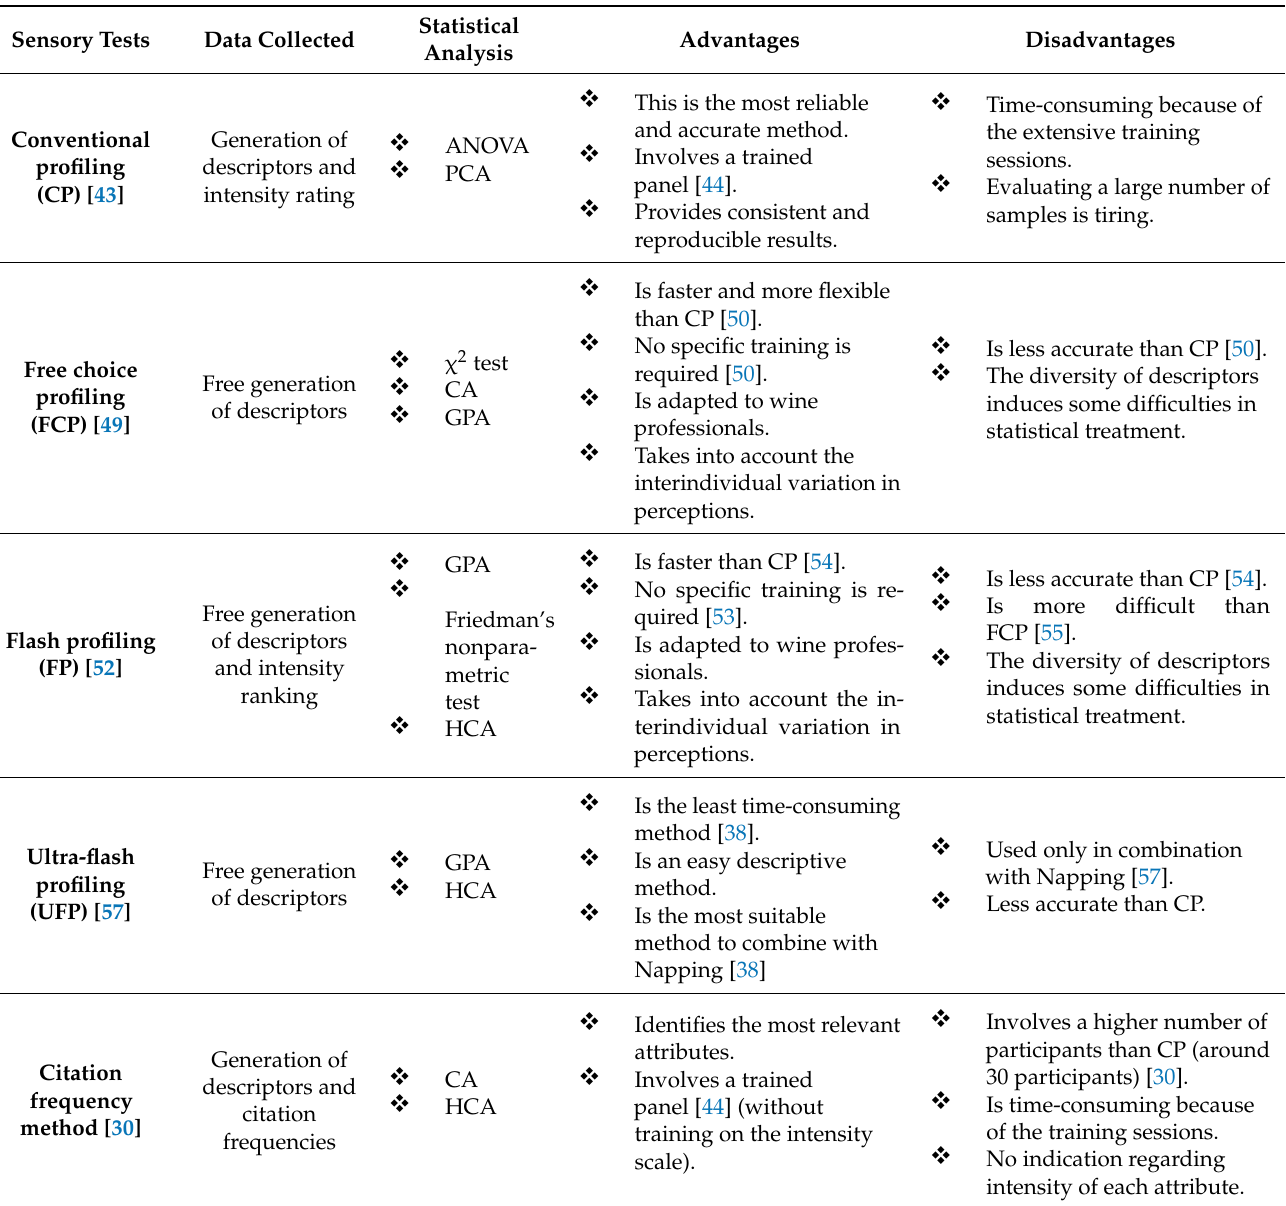
Table 2. Inventory of perceptual methodologies used to describe sensory space. Statistical analysis—ANOVA: analysis of variance; PCA: principal component analysis; CA: correspondence analysis; GPA: generalized procrustes analysis; HCA: Table 1. Inventory of perceptual methodologies used to evaluate sensory space. Statistical analysis—MDS: multi-dimen- Table 1. Inventory of perceptual methodologies used to evaluate sensory space. Statistical analysis—MDS: multi-dimen- hierarchical cluster analysis. sional scaling; HCA: hierarchical cluster analysis; MFA: multiple factor analysis; PCA: principal component analysis; sional scaling; HCA: hierarchical cluster analysis; MFA: multiple factor analysis; PCA: principal component analysis; Table 1. Inventory of perceptual methodologies used to evaluate sensory space. Statistical analysis—MDS: multi-dimen- ANOVA: analysis of variance. Table 1. Inventory of perceptual methodologies used to evaluate sensory space. Statistical analysis—MDS: multi-dimen- ANOVA: analysis of variance. Table 1. Inventory of perceptual methodologies used to evaluate sensory space. Statistical analysis—MDS: multi-dimen- sional scaling; HCA: hierarchical cluster analysis; MFA: multiple factor analysis; PCA: principal component analysis; sional scaling; HCA: hierarchical cluster analysis; MFA: multiple factor analysis; PCA: principal component analysis; Table 1. Inventory of perceptual methodologies used to evaluate sensory space. Statistical analysis—MDS: multi-dimen- sional scaling; HCA: hierarchical cluster analysis; MFA: multiple factor analysis; PCA: principal component analysis; ANOVA: analysis of variance. Table 1. Inventory of perceptual methodologies used to evaluate sensory space. Statistical analysis—MDS: multi-dimen- ANOVA: analysis of variance. sional scaling; HCA: hierarchical cluster analysis; MFA: multiple factor analysis; PCA: principal component analysis; ANOVA: analysis of variance. sional scaling; HCA: hierarchical cluster analysis; MFA: multiple factor analysis; PCA: principal component analysis; ANOVA: analysis of variance. ANOVA: analysis of variance. Table 1. Inventory of perceptual methodologies used to evaluate sensory space. Statistical analysis—MDS: multi-dimen- sional scaling; HCA: hierarchical cluster analysis; MFA: multiple factor analysis; PCA: principal component analysis; panel [44]. Table 1. Inventory of perceptual methodologies used to evaluate sensory space. Statistical analysis—MDS: multi-dimen- Table 1. Inventory of perceptual methodologies used to evaluate sensory space. Statistical analysis—MDS: multi-dimen- ANOVA: analysis of variance. Provides consistent and Table 1. Inventory of perceptual methodologies used to evaluate sensory space. Statistical analysis—MDS: multi-dimen- sional scaling; HCA: hierarchical cluster analysis; MFA: multiple factor analysis; PCA: principal component analysis; Table 1. Inventory of perceptual methodologies used to evaluate sensory space. Statistical analysis—MDS: multi-dimen- sional scaling; HCA: hierarchical cluster analysis; MFA: multiple factor analysis; PCA: principal component analysis; reproducible results. Table 1. Inventory of perceptual methodologies used to evaluate sensory space. Statistical analysis—MDS: multi-dimen- sional scaling; HCA: hierarchical cluster analysis; MFA: multiple factor analysis; PCA: principal component analysis; ANOVA: analysis of variance. Table 1. Inventory of perceptual methodologies used to evaluate sensory space. Statistical analysis—MDS: multi-dimen- sional scaling; HCA: hierarchical cluster analysis; MFA: multiple factor analysis; PCA: principal component analysis; ANOVA: analysis of variance. Table 1. Inventory of perceptual methodologies used to evaluate sensory space. Statistical analysis—MDS: multi-dimen- sional scaling; HCA: hierarchical cluster analysis; MFA: multiple factor analysis; PCA: principal component analysis; ANOVA: analysis of variance. sional scaling; HCA: hierarchical cluster analysis; MFA: multiple factor analysis; PCA: principal component analysis; ANOVA: analysis of variance. Is faster and more flexible sional scaling; HCA: hierarchical cluster analysis; MFA: multiple factor analysis; PCA: principal component analysis; ANOVA: analysis of variance. Table 1. Inventory of perceptual methodologies used to evaluate sensory space. Statistical analysis—MDS: multi-dimen- ANOVA: analysis of variance. than CP [50]. ANOVA: analysis of variance. sional scaling; HCA: hierarchical cluster analysis; MFA: multiple factor analysis; PCA: principal component analysis; ANOVA: analysis of variance. Table 1. Inventory of perceptual methodologies used to evaluate sensory space. Statistical analysis—MDS: multi-dimen- Table 1. Inventory of perceptual methodologies used to evaluate sensory space. Statistical analysis—MDS: multi-dimen- professionals. Table 1. Inventory of perceptual methodologies used to evaluate sensory space. Statistical analysis—MDS: multi-dimen- Table 1. Inventory of perceptual methodologies used to evaluate sensory space. Statistical analysis—MDS: multi-dimen- sional scaling; HCA: hierarchical cluster analysis; MFA: multiple factor analysis; PCA: principal component analysis; Table 1. Inventory of perceptual methodologies used to evaluate sensory space. Statistical analysis—MDS: multi-dimen- sional scaling; HCA: hierarchical cluster analysis; MFA: multiple factor analysis; PCA: principal component analysis; Table 1. Inventory of perceptual methodologies used to evaluate sensory space. Statistical analysis—MDS: multi-dimen- sional scaling; HCA: hierarchical cluster analysis; MFA: multiple factor analysis; PCA: principal component analysis; sional scaling; HCA: hierarchical cluster analysis; MFA: multiple factor analysis; PCA: principal component analysis; ANOVA: analysis of variance. sional scaling; HCA: hierarchical cluster analysis; MFA: multiple factor analysis; PCA: principal component analysis; ANOVA: analysis of variance. sional scaling; HCA: hierarchical cluster analysis; MFA: multiple factor analysis; PCA: principal component analysis; ANOVA: analysis of variance. ANOVA: analysis of variance. Table 1. Inventory of perceptual methodologies used to evaluate sensory space. Statistical analysis—MDS: multi-dimen- ANOVA: analysis of variance. ANOVA: analysis of variance. Table 1. Inventory of perceptual methodologies used to evaluate sensory space. Statistical analysis—MDS: multi-dimen- sional scaling; HCA: hierarchical cluster analysis; MFA: multiple factor analysis; PCA: principal component analysis; sional scaling; HCA: hierarchical cluster analysis; MFA: multiple factor analysis; PCA: principal component analysis; ANOVA: analysis of variance. Table 1. Inventory of perceptual methodologies used to evaluate sensory space. Statistical analysis—MDS: multi-dimen- Is faster than CP [54]. ANOVA: analysis of variance. sional scaling; HCA: hierarchical cluster analysis; MFA: multiple factor analysis; PCA: principal component analysis; Table 1. Inventory of perceptual methodologies used to evaluate sensory space. Statistical analysis—MDS: multi-dimen- ANOVA: analysis of variance. sional scaling; HCA: hierarchical cluster analysis; MFA: multiple factor analysis; PCA: principal component analysis; ANOVA: analysis of variance. Table 1. Inventory of perceptual methodologies used to evaluate sensory space. Statistical analysis—MDS: multi-dimen- sional scaling; HCA: hierarchical cluster analysis; MFA: multiple factor analysis; PCA: principal component analysis; Table 1. Inventory of perceptual methodologies used to evaluate sensory space. Statistical analysis—MDS: multi-dimen- Table 1. Inventory of perceptual methodologies used to evaluate sensory space. Statistical analysis—MDS: multi-dimen- ANOVA: analysis of variance. Table 1. Inventory of perceptual methodologies used to evaluate sensory space. Statistical analysis—MDS: multi-dimen- sional scaling; HCA: hierarchical cluster analysis; MFA: multiple factor analysis; PCA: principal component analysis; sional scaling; HCA: hierarchical cluster analysis; MFA: multiple factor analysis; PCA: principal component analysis; Table 1. Inventory of perceptual methodologies used to evaluate sensory space. Statistical analysis—MDS: multi-dimen- sional scaling; HCA: hierarchical cluster analysis; MFA: multiple factor analysis; PCA: principal component analysis; ANOVA: analysis of variance. Table 1. Inventory of perceptual methodologies used to evaluate sensory space. Statistical analysis—MDS: multi-dimen- ANOVA: analysis of variance. Table 1. Inventory of perceptual methodologies used to evaluate sensory space. Statistical analysis—MDS: multi-dimen- sional scaling; HCA: hierarchical cluster analysis; MFA: multiple factor analysis; PCA: principal component analysis; ANOVA: analysis of variance. sional scaling; HCA: hierarchical cluster analysis; MFA: multiple factor analysis; PCA: principal component analysis; sional scaling; HCA: hierarchical cluster analysis; MFA: multiple factor analysis; PCA: principal component analysis; ANOVA: analysis of variance. ANOVA: analysis of variance. ANOVA: analysis of variance. Table 1. Inventory of perceptual methodologies used to evaluate sensory space. Statistical analysis—MDS: multi-dimen- Table 1. Inventory of perceptual methodologies used to evaluate sensory space. Statistical analysis—MDS: multi-dimen- sional scaling; HCA: hierarchical cluster analysis; MFA: multiple factor analysis; PCA: principal component analysis; sional scaling; HCA: hierarchical cluster analysis; MFA: multiple factor analysis; PCA: principal component analysis; Table 1. Inventory of perceptual methodologies used to evaluate sensory space. Statistical analysis—MDS: multi-dimen- ANOVA: analysis of variance. ANOVA: analysis of variance. Table 1. Inventory of perceptual methodologies used to evaluate sensory space. Statistical analysis—MDS: multi-dimen- Table 1. Inventory of perceptual methodologies used to evaluate sensory space. Statistical analysis—MDS: multi-dimen- Table 1. Inventory of perceptual methodologies used to evaluate sensory space. Statistical analysis—MDS: multi-dimen- sional scaling; HCA: hierarchical cluster analysis; MFA: multiple factor analysis; PCA: principal component analysis; sional scaling; HCA: hierarchical cluster analysis; MFA: multiple factor analysis; PCA: principal component analysis; sional scaling; HCA: hierarchical cluster analysis; MFA: multiple factor analysis; PCA: principal component analysis; sional scaling; HCA: hierarchical cluster analysis; MFA: multiple factor analysis; PCA: principal component analysis; ANOVA: analysis of variance. ANOVA: analysis of variance. ANOVA: analysis of variance. Table 1. Inventory of perceptual methodologies used to evaluate sensory space. Statistical analysis—MDS: multi-dimen- ANOVA: analysis of variance. sional scaling; HCA: hierarchical cluster analysis; MFA: multiple factor analysis; PCA: principal component analysis; ANOVA: analysis of